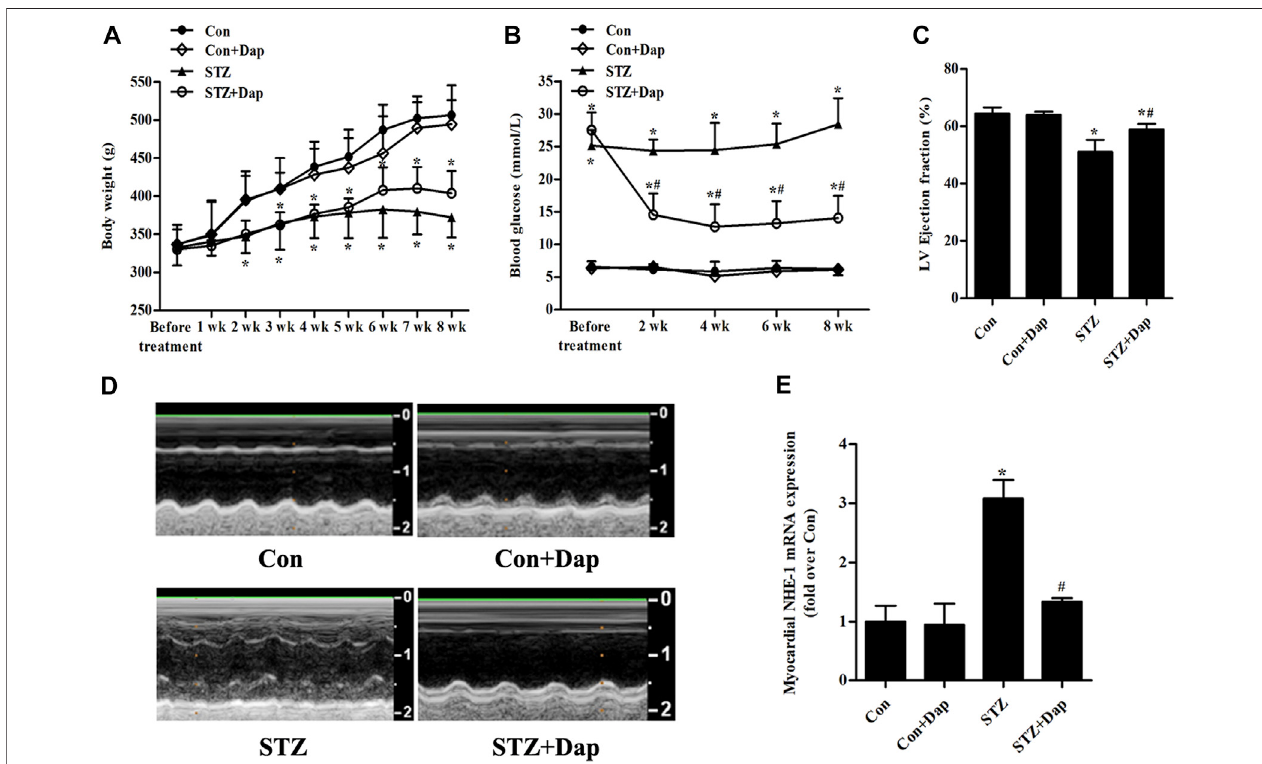
FIGURE 1 | Effects of dapagli fl ozin (DAP) on body weight, non-fasting blood glucose and left ventricular (LV) dysfunction in diabetic rats. Control (Con + Dap) and STZ-induced diabetic rats (STZ + Dap) were administrated Dap by gavage at the daily dose of 1 mg/ kg for 8 weeks (A) Body weight was recorded weekly (B) Non- fasting blood glucose was measured at 9 AM on a bi-weekly basis (C) Echocardiography was used to measure LV ejection fraction (D) LV echocardiographic representative images from each group. n (cid:1) 7 (E) The mRNA expression of myocardial NHE-1. n (cid:1) 7. Data are expressed as the mean ± SD. * p < 0.05 vs. Con; # p < 0.05 vs.